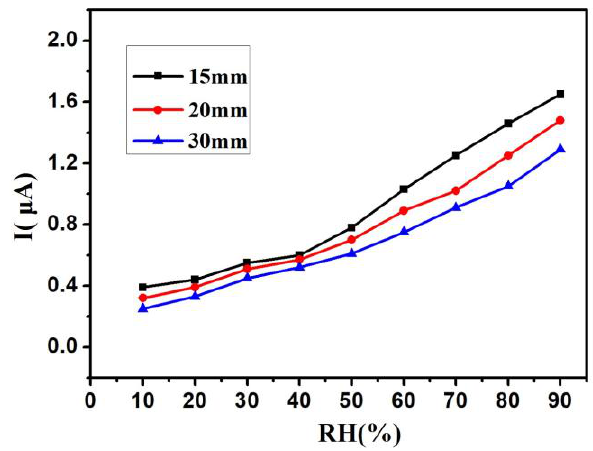
Figure 6. I-RH curves at an applied voltage of 1 V with different distances between the UV LED and the sample under UV LED (λ = 300 nm, P =150 μW).